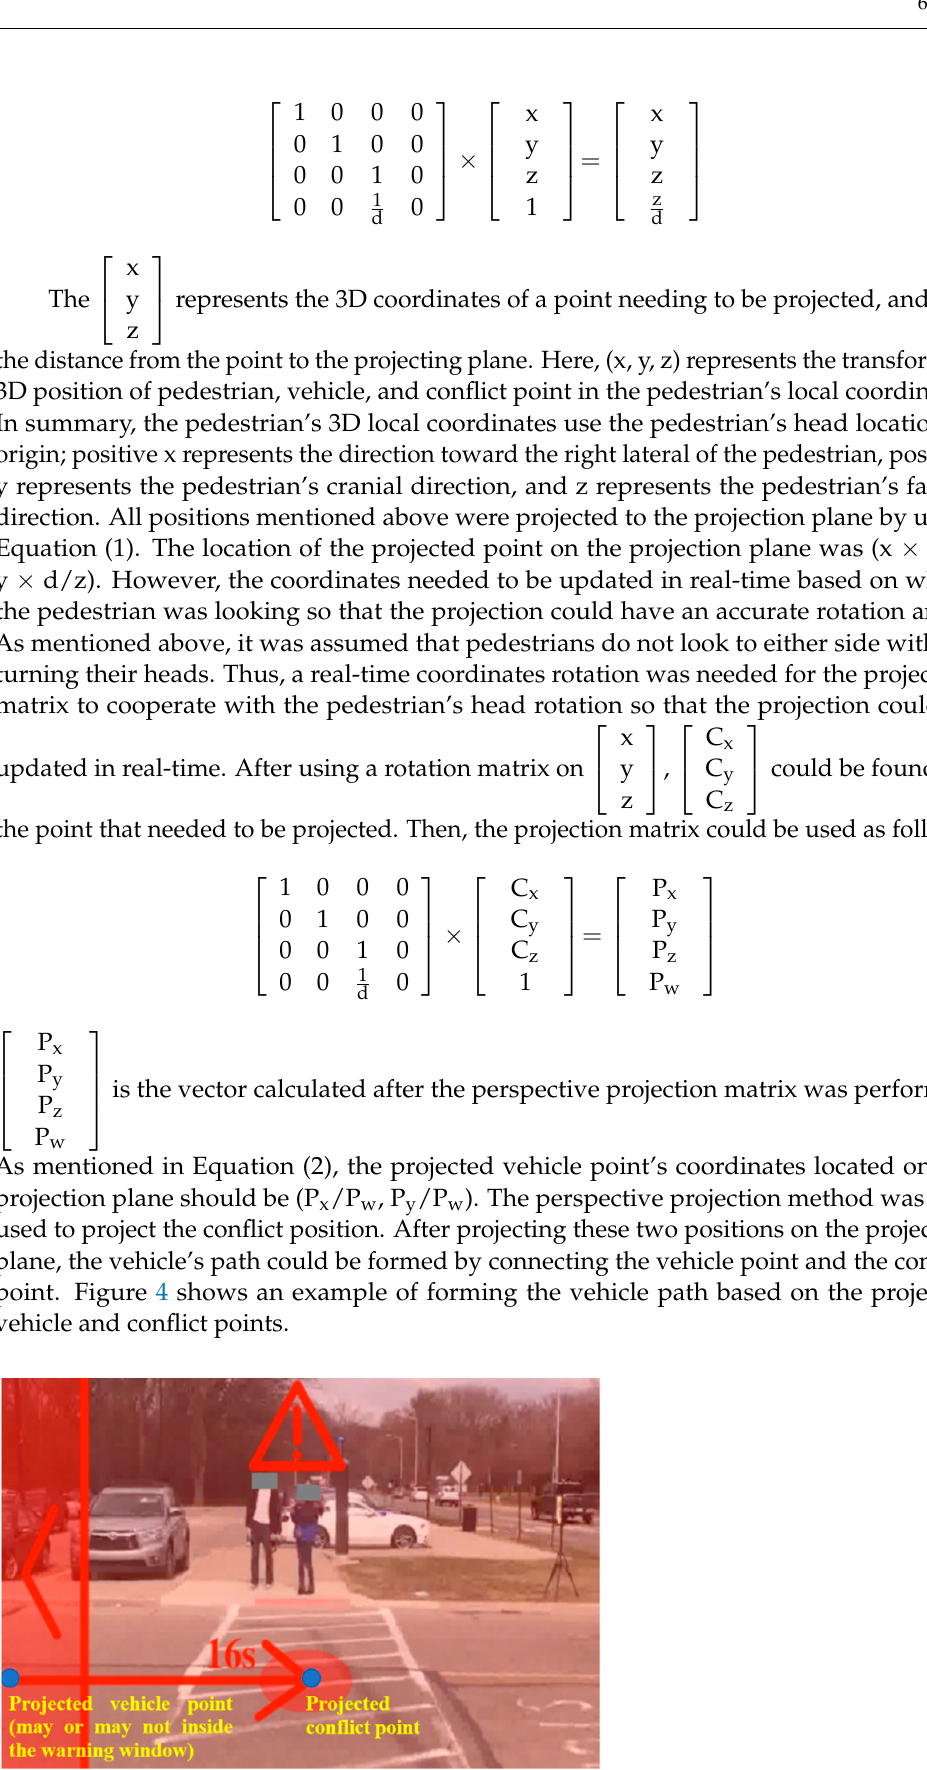
Figure 4. An example of forming an arrow based on projected points.